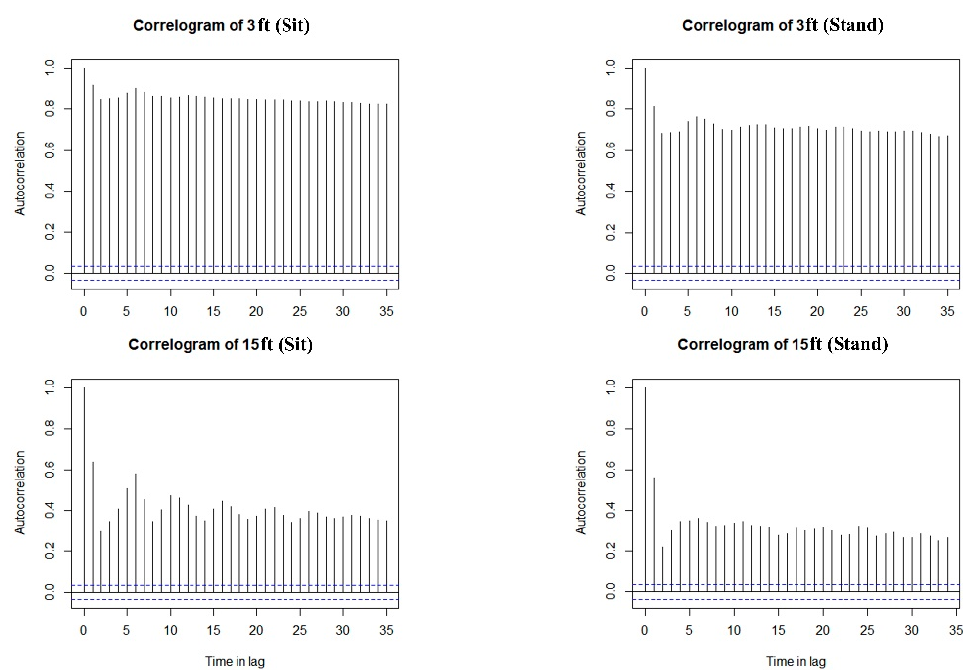
Figure 6. RSSI over 3 min at 3 ft and 15 ft (Sit, Stand).